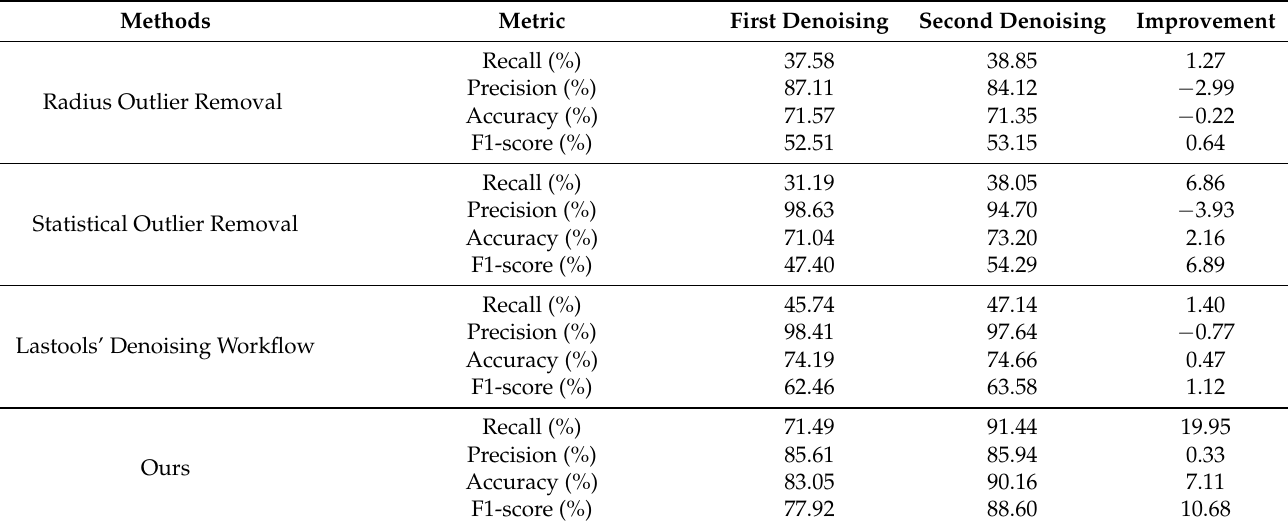
Figure 11. Visualization of the effect of single-scale versus multiscale neighborhood features on denoising results on the four datasets. Table 7. Performance evaluation of denoising by multiple denoising, using different denoising approaches in the water